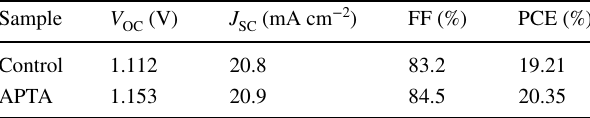
Table 1 Summarized photovoltaic parameters obtained from the J − V curves in reverse scans